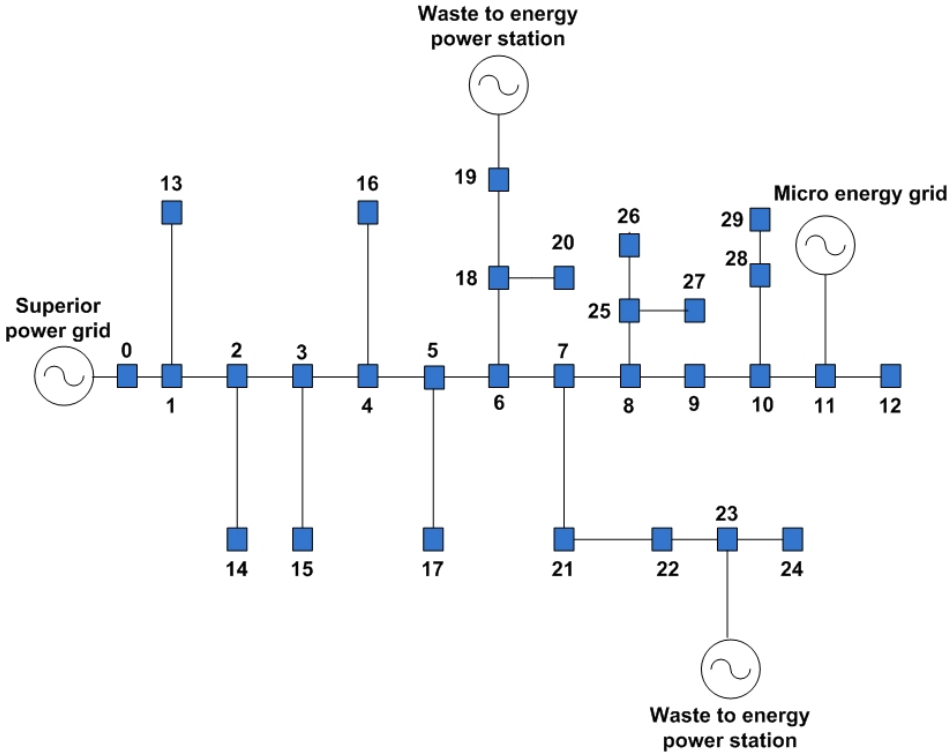
Figure 3. A micro-energy grid of an agricultural park